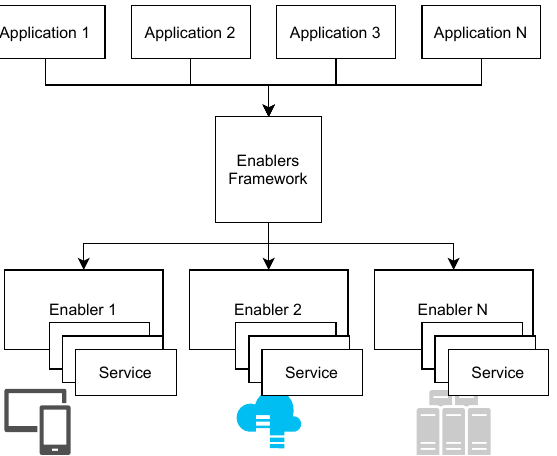
Figure 1. Interoperability between applications and enablers. Each enabler can have different services that can be accessed by different applications only through the EF